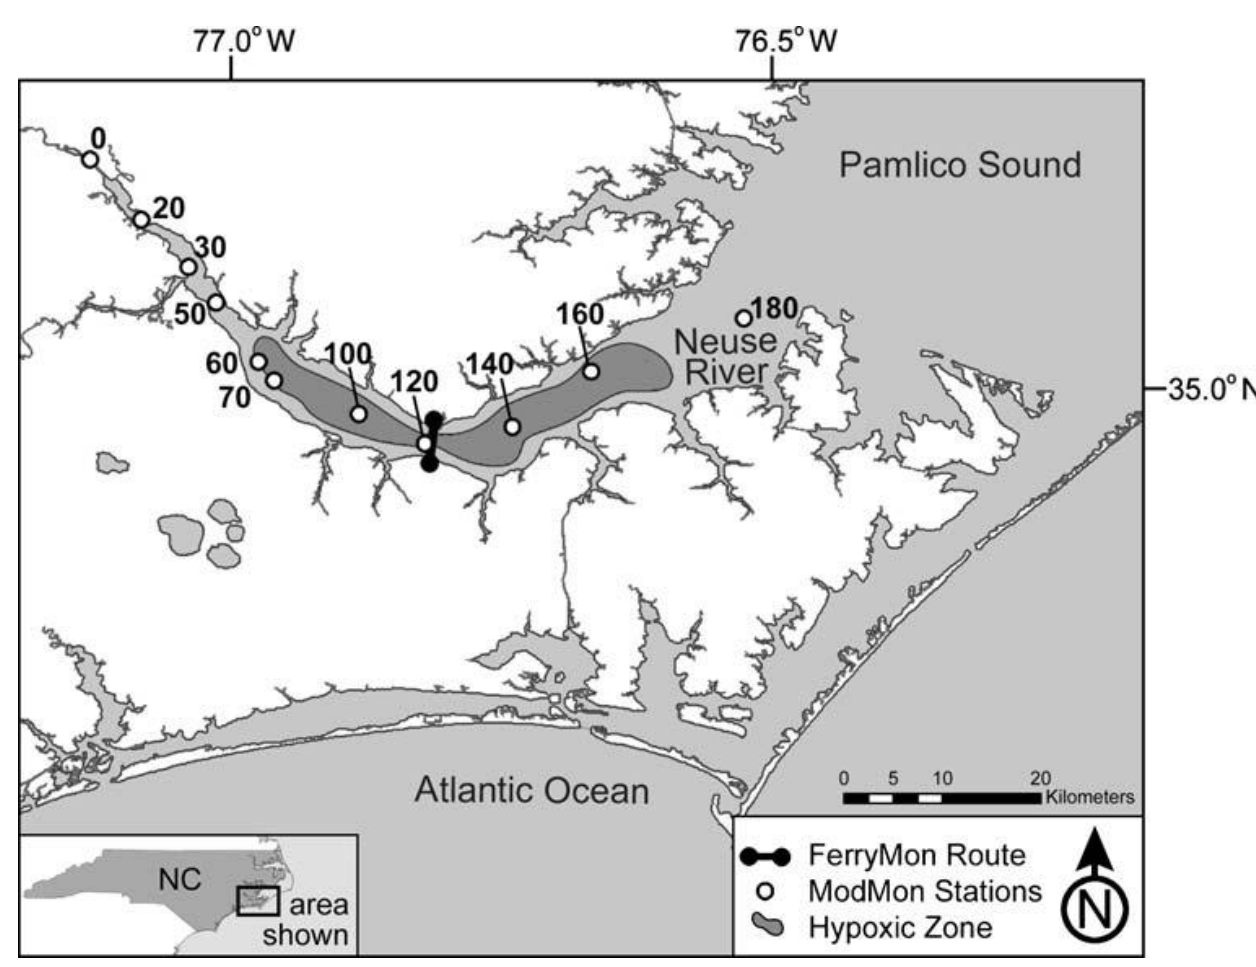
Figure 1. The Neuse River-Pamlico Sound Estuarine System including ModMon stations and FerryMon